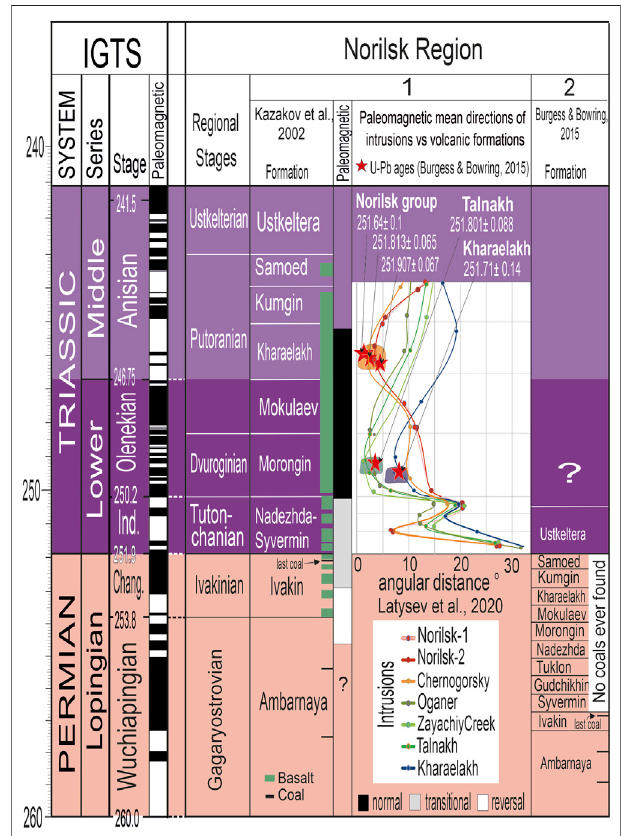
FIGURE 2 | Correlation of Permian-Triassic transition of Norilsk region with the International Geologic Time Scale (IGTS) (Henderson et al., 2012). White dashed lines - correlation according to regional fl ora and fauna. The data on the paleomagnetic (P/M) analysis of the geomagnetic secular variations recorded in the intrusions and their correlation with the Siberian Traps volcanic sequences in Norilsk region is modi fi ed from Latyshev et al. (2020); the paleomagnetic data combined with the CA-IDTIMS U-Pb dates obtained from Norilsk group intrusions (Norilsk-1, and Chernogorsky-1) and from Talnakh and Kharaelakh intrusions are from Burgess and Bowring (2015). Distribution of coals from Cherepovskiy (2001); distribution of traps and their thickness and the chroniostratigraphic position of sills and intrusions in left column (1) according to Krivolutskaya (2016), Rad ’ ko (2016), Ryabov et al. (2014) and in right column (2) by Burgess and Bowring (2015).